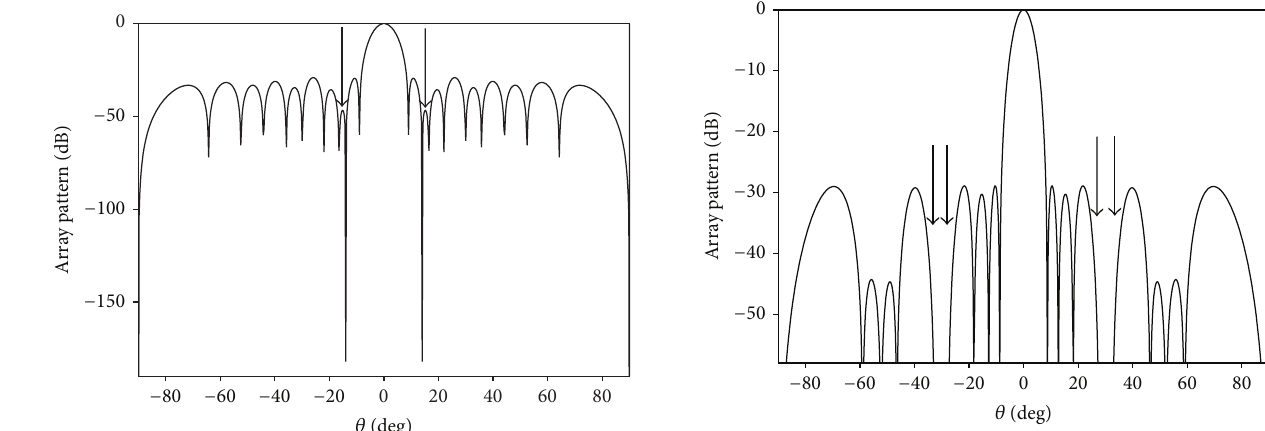
Figure 5: Radiation pattern achieved by controlling the amplitude only with a null depth level deeper than that of the first example having one null at 14 ∘ .